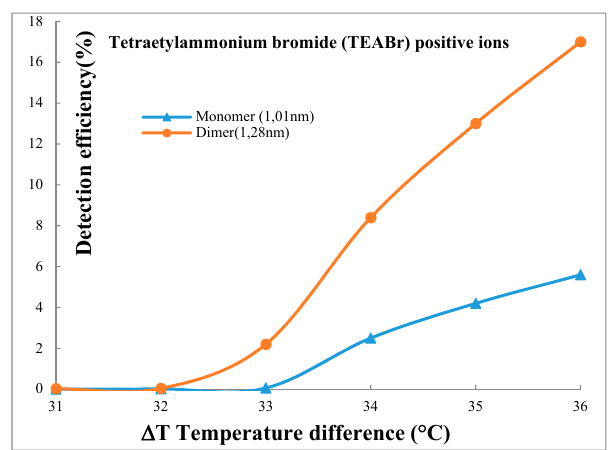
Figure 7. Detection efficiency of the CPC for TEABr and TBABr ions for different Ts.